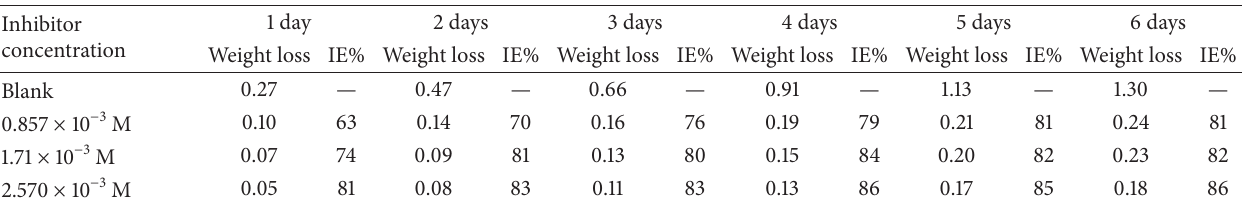
Table 1: Weight loss values and calculated inhibition efficiency for mild steel corrosion in 0.1M HCl in the presence and absence of different concentrations of inhibitors.